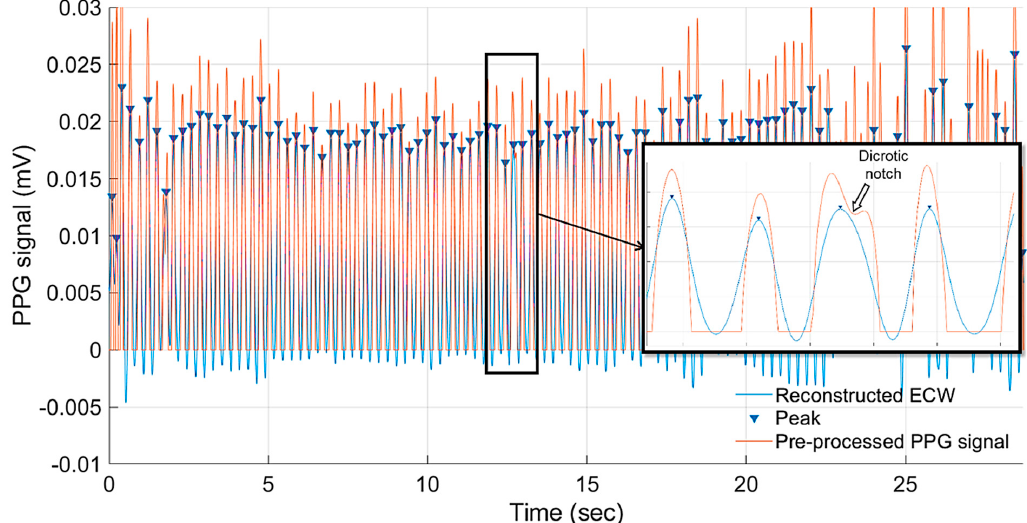
Figure 6. Detected cardiac peaks based on the reconstructed embryonic cardiac wave (ECW) in comparison to a pre-processed PPG segment obtained from an incubated fertile egg at embryonic day ED09. The magnified graph shows that the developed ECW extraction algorithm is not susceptible to false readings of the dicrotic notch.